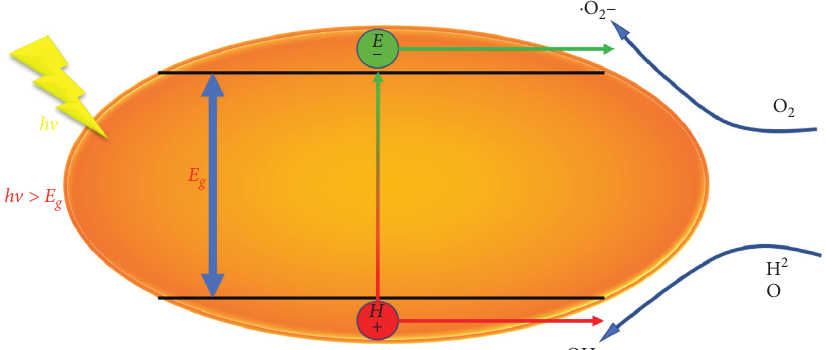
Figure 5: Schematic representation of the energetics of ROS